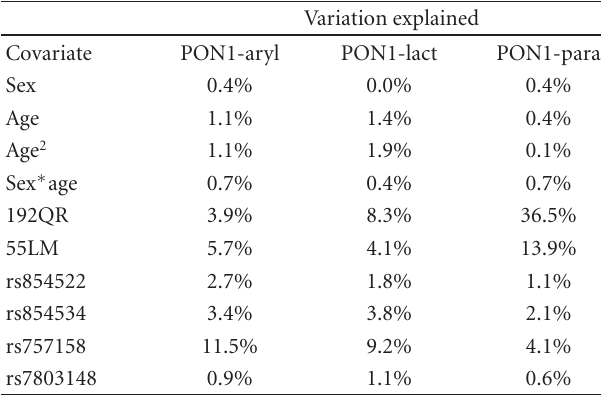
Table 1: Proportion of variance explained by covariates. The pro- portion of variation explained by each significant variable was cal- culated for the three substrates by adding each to a polygenic model in